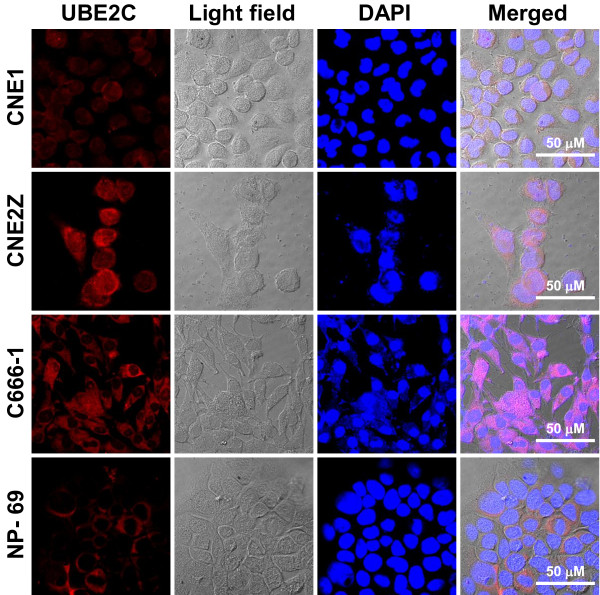
Representative fluorescent photographs of UBE2C protein expression in various NPC cell lines and NP-69 cells. Cells grown on glass coverslips were incubated with primary rabbit-anti human UBE2C antibody overnight; the antigenic site of UBE2C was located by TRITC-conjugated goat anti-rabbit IgG (H+L) and photographed by confocal microscopy. Scale bars = 100 μM.